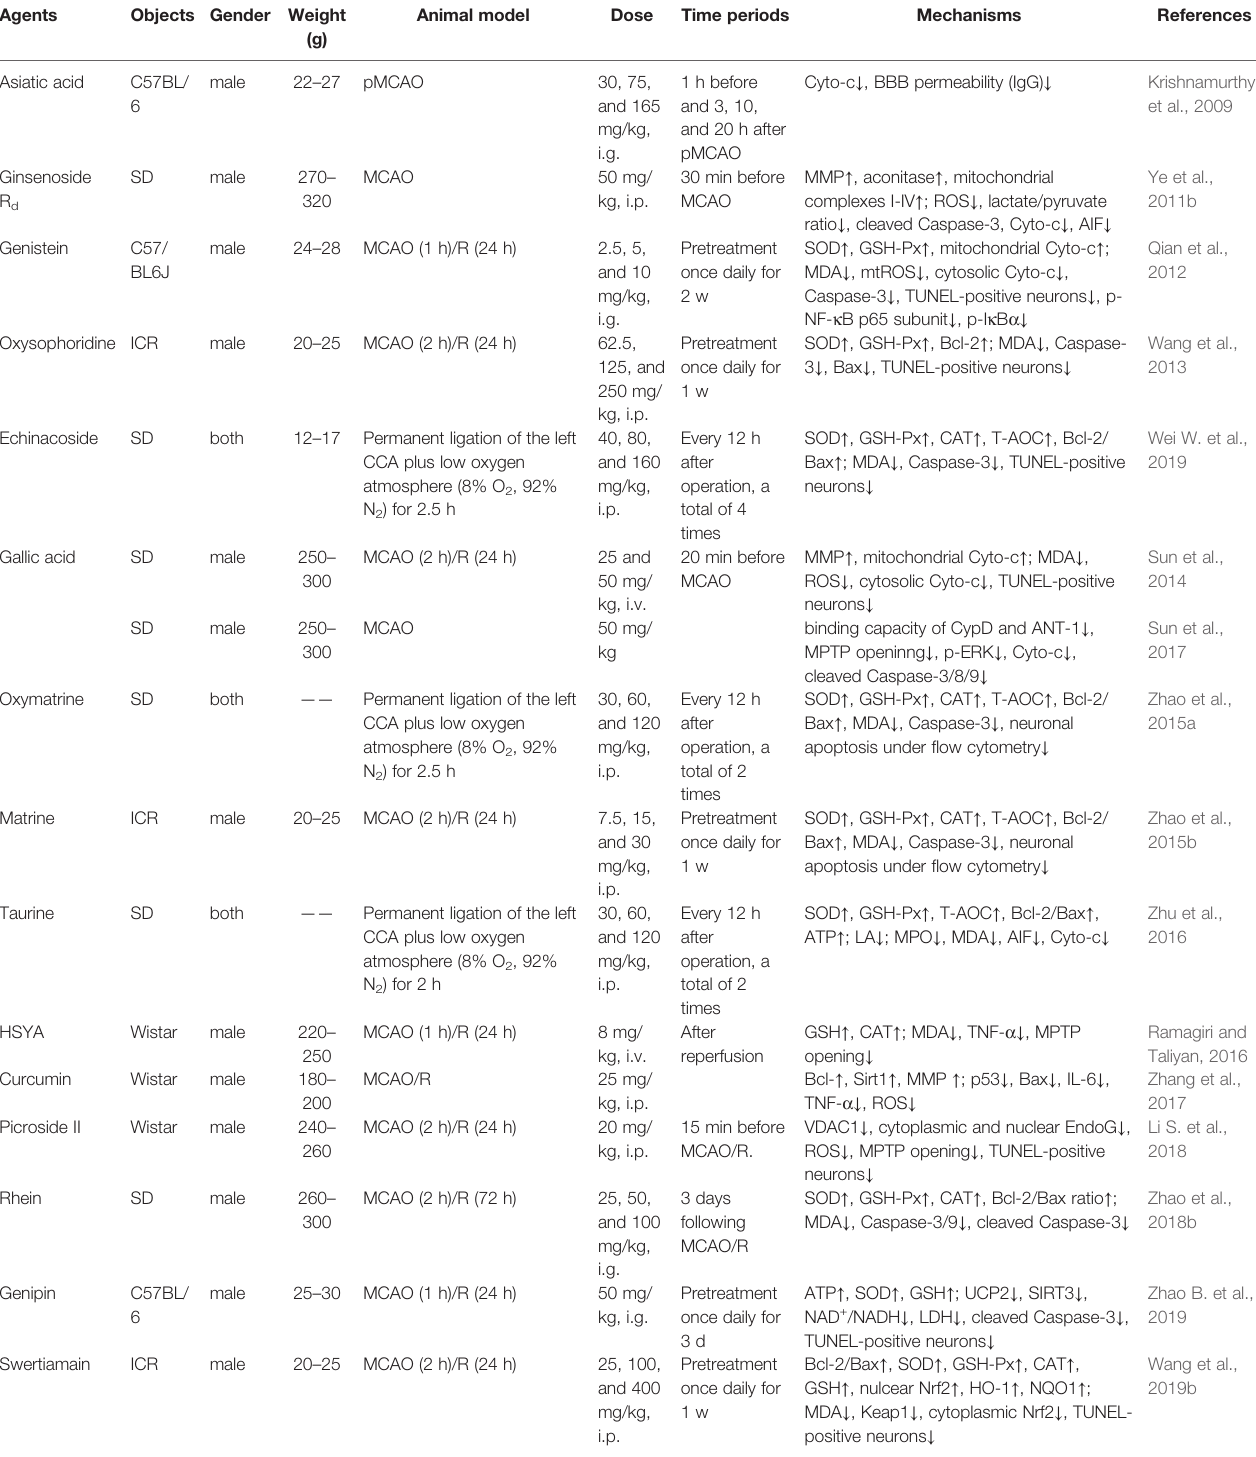
TABLE 6 | The in vivo mechanism underlying the inhibition of MPTP opening-induced neuronal apoptosis by monomeric compounds in the treatment of ischemic